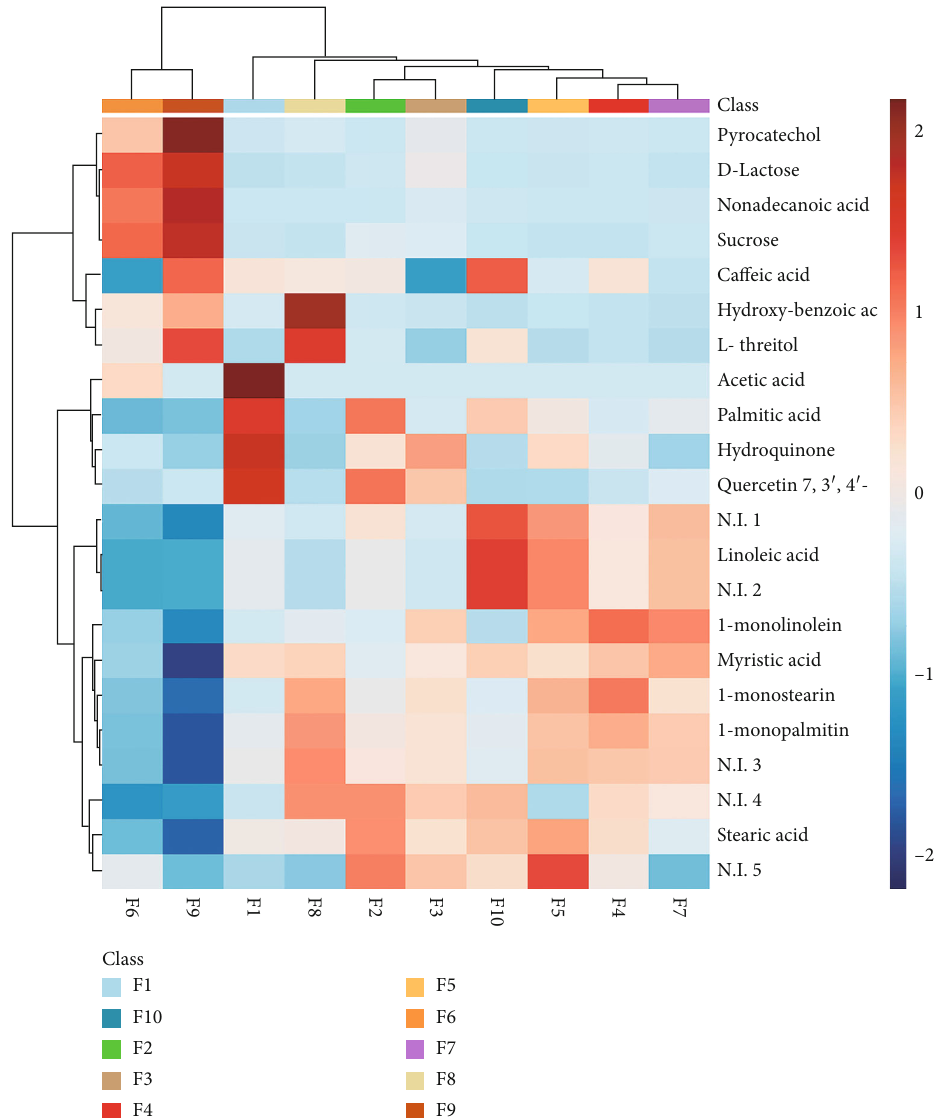
Figure 2: Heatmap representation of metabolite correlations in herbal infusions. Correlations coe ffi cients were calculated based on Pearson ’ s